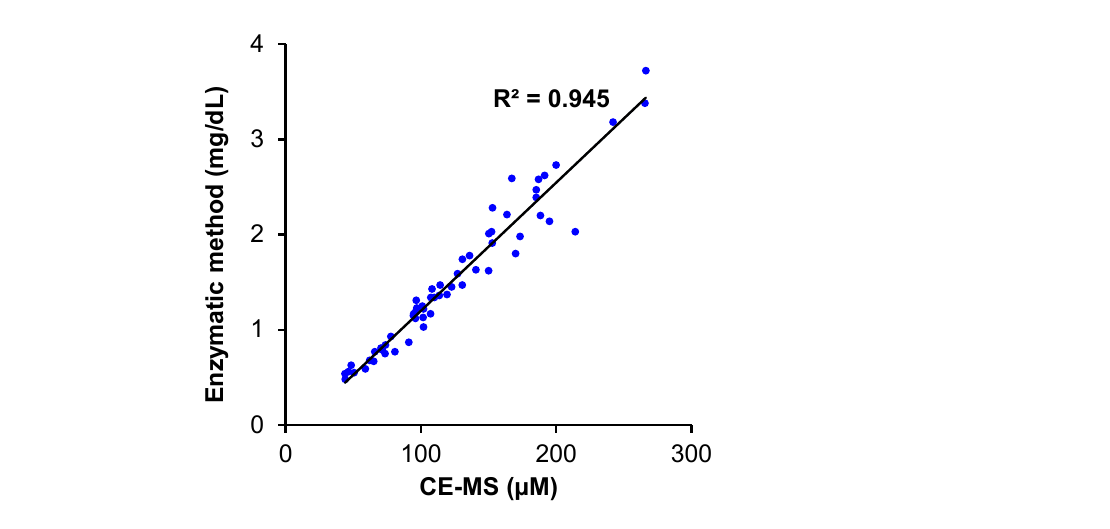
Figure A1. Comparison of creatinine concentration of enzymatic method and metabolomic profile. The correlation (Pearson correlation) shows p < 0.0001.